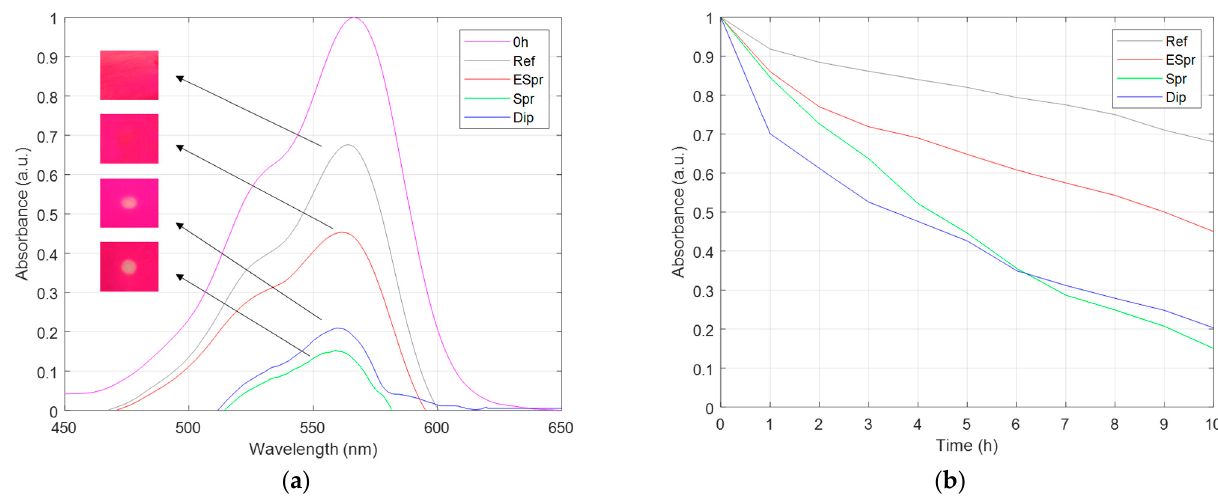
Figure 8. Photocatalytic degradation of RhB organic dye under UV light irradiation after depositing it into the functional coatings: ( a ) Final spectrums of dye degradation of all samples for a 10 h photocatalytic test; ( b ) RhB maximum peak decrease along time for each sample.